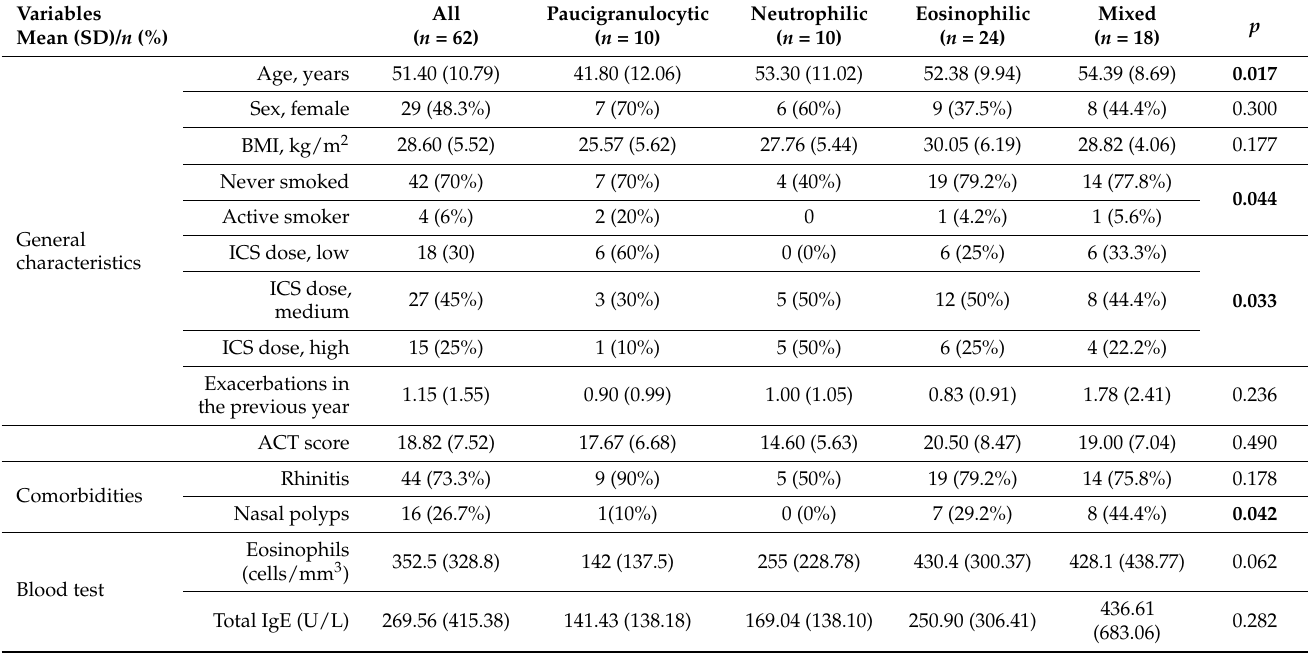
Table 1. Clinical, functional, and light microscopy characteristics based on the induced sputum